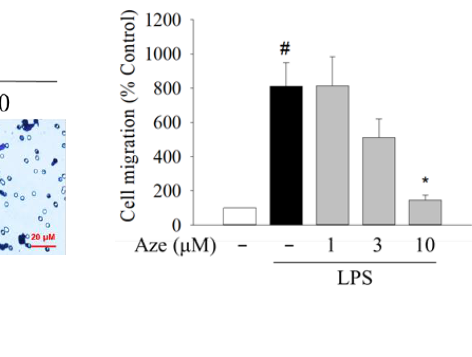
Figure 5. Aze reduced the LPS-stimulated protein levels of COX2 and iNOS in BV2 cells. Cells were co-treated with LPS (1 μg/mL), and the indicated concentrations of Aze for 24 h. Control cells were treated with vehicle alone. The expressions of COX2 ( A ) and iNOS ( B ) were determined by Western blotting analysis, as described in the Materials and Methods. Representative blots are shown. Data are presented as the mean ± SEM from three independent experiments. # p < 0.05 and * p < 0.05 vs. vehicle-treated control and LPS-treated cells, respectively.